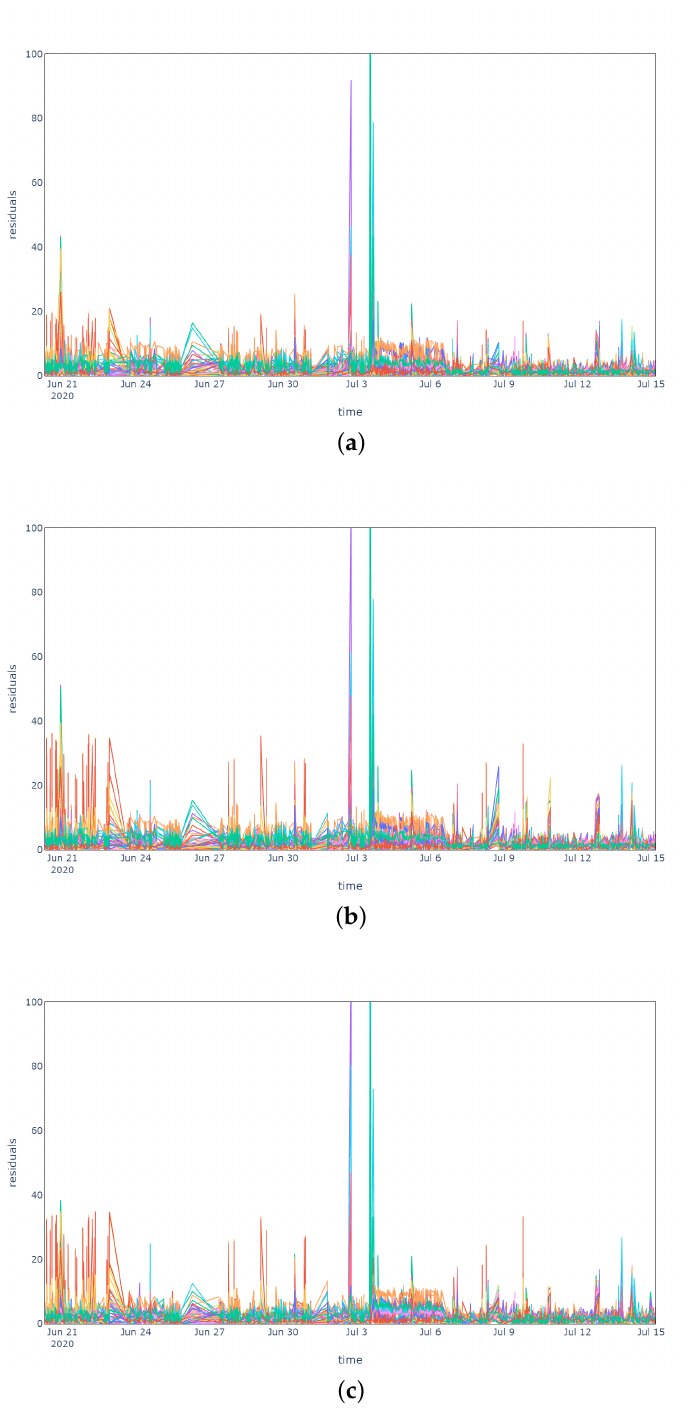
Figure 5. ( a ) shows the KPIs (5) associated to all sensors without the removal of outliers before and after the break, while ( b , c ) represent the KPIs (5) over time after the IQR and MC methods were applied respectively for the outlier removal